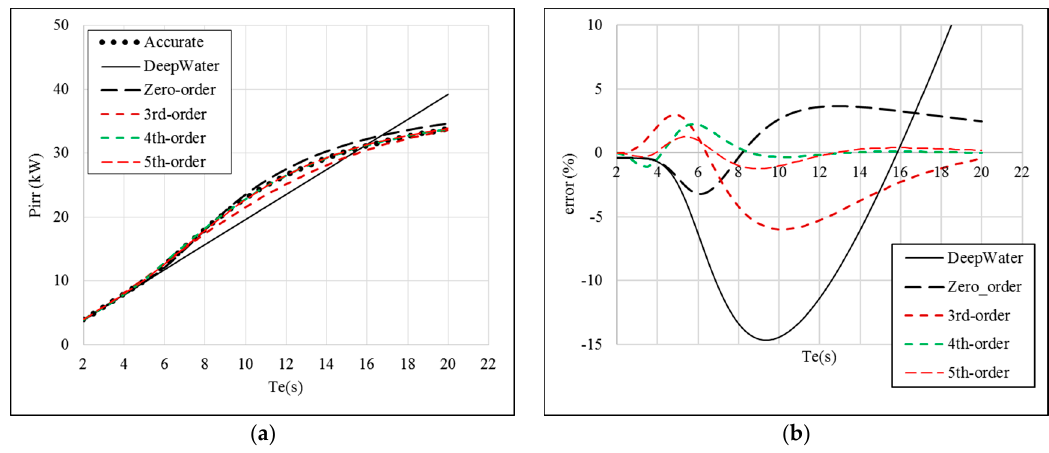
Figure 8. Comparison of the calculated wave power and the corresponding error using different methods for JONSWAP spectra of H m 0 = 2 m (water depth = 25 m). ( a ) Calculated wave power; ( b ) Error.